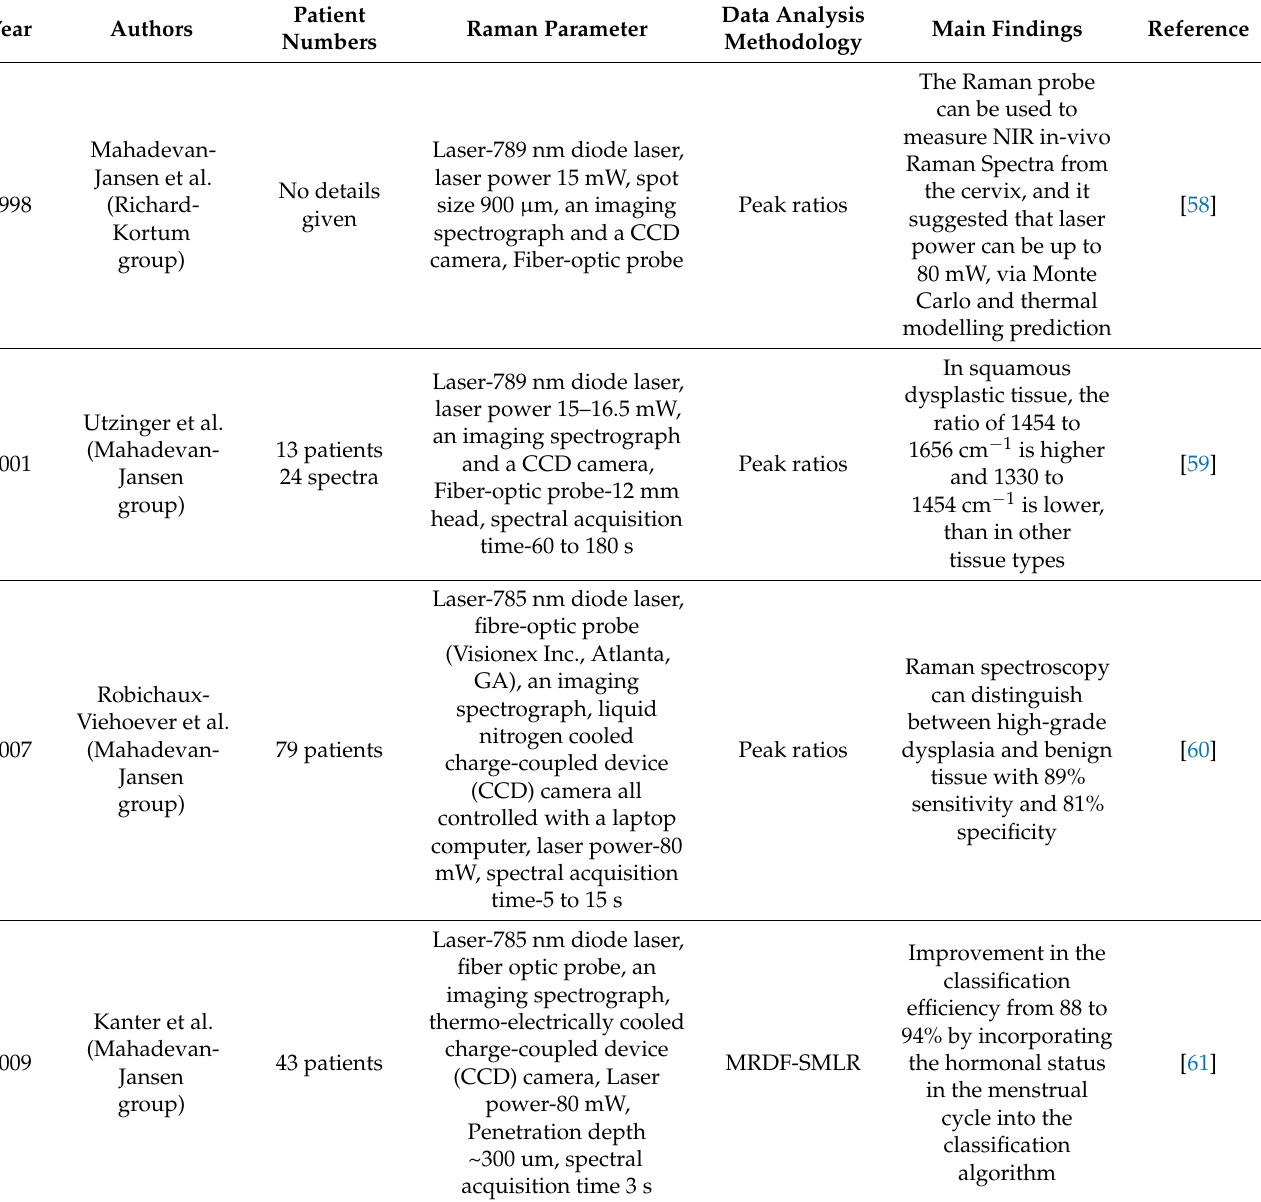
Table 3. Application of Raman spectroscopy in cervical tissues (in